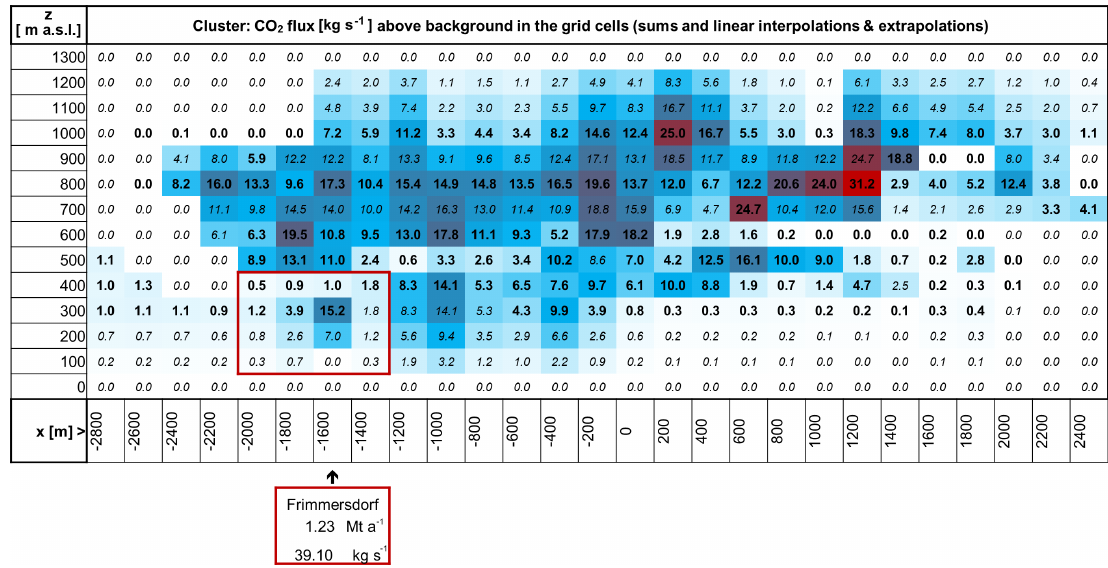
Figure 7. The same as Fig. 4 but for the mixed plume of the whole cluster on the northern transect. The weak plume from Frimmersdorf, which is only 4km away from this cross section could be isolated below 450ma.m.s.l. The confirmation was done with an analysis at higher resolution. The layer between 350 and 450m (centred at 400m) has enough measurement points allowing the small lower plume to be separated from the main plume from Niederaußem (probably the whole width of about 4.5km) and the two plumes from Neurath old and new. See Fig. 8 for the separation on a cross section upwind of Frimmersdorf, which is closer to the three other